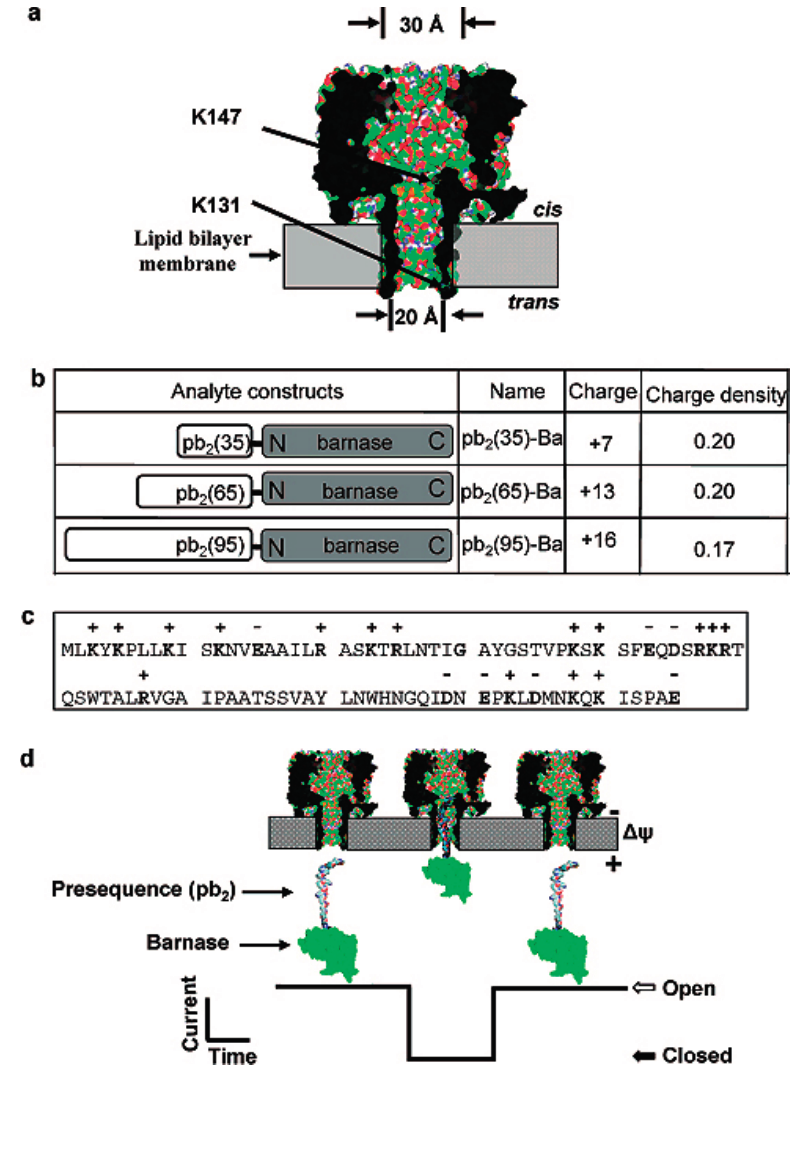
Figure 4. Engineered nanopores and pb 2 -Ba proteins for protein detecting: ( a ) Two mutations: K131 and K147, as shown by arrows; ( b ) Three different lengths and different charge densities of yeast precytochrome b 2 (pb 2 ) were fused to the N-terminus of barnase (Ba); ( c ) The panel represents the amino acid sequence of 95 residues; ( d ) Illustration shows how pb 2 -Ba protein divides into the nanopore from the trans side. Reproduced with permission from